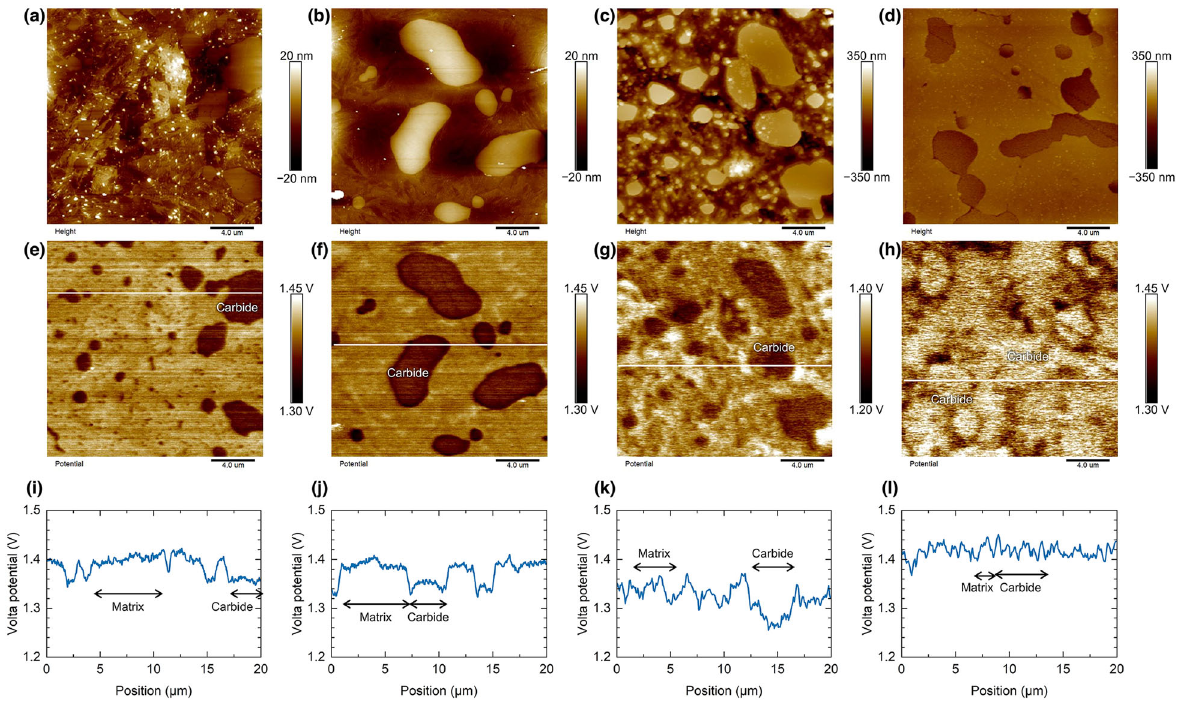
Fig. 10 Sur fi cial potential evolution during immersion. a – d Topography and e – h the corresponding Volta potential difference maps obtained before and after immersion of the 16Cr steel samples quenched from 800 and 1100 °C in the 0.5 M H 2 SO 4 solution for 1 h. i – l Line pro fi les of the Volta potential constructed along the white lines in panels e – h